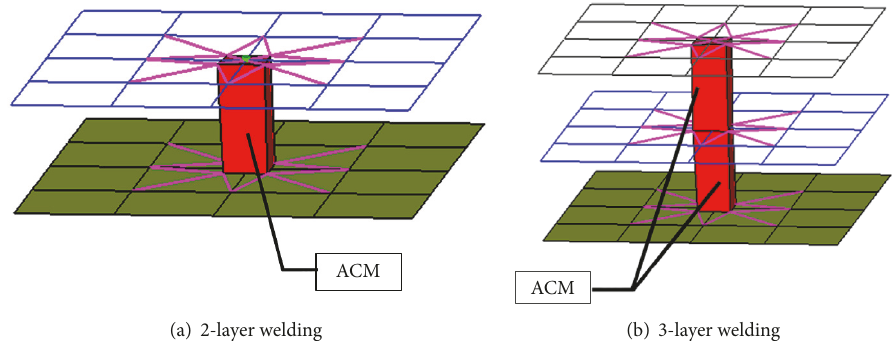
Figure 6: Schematic of ACM welding spot.